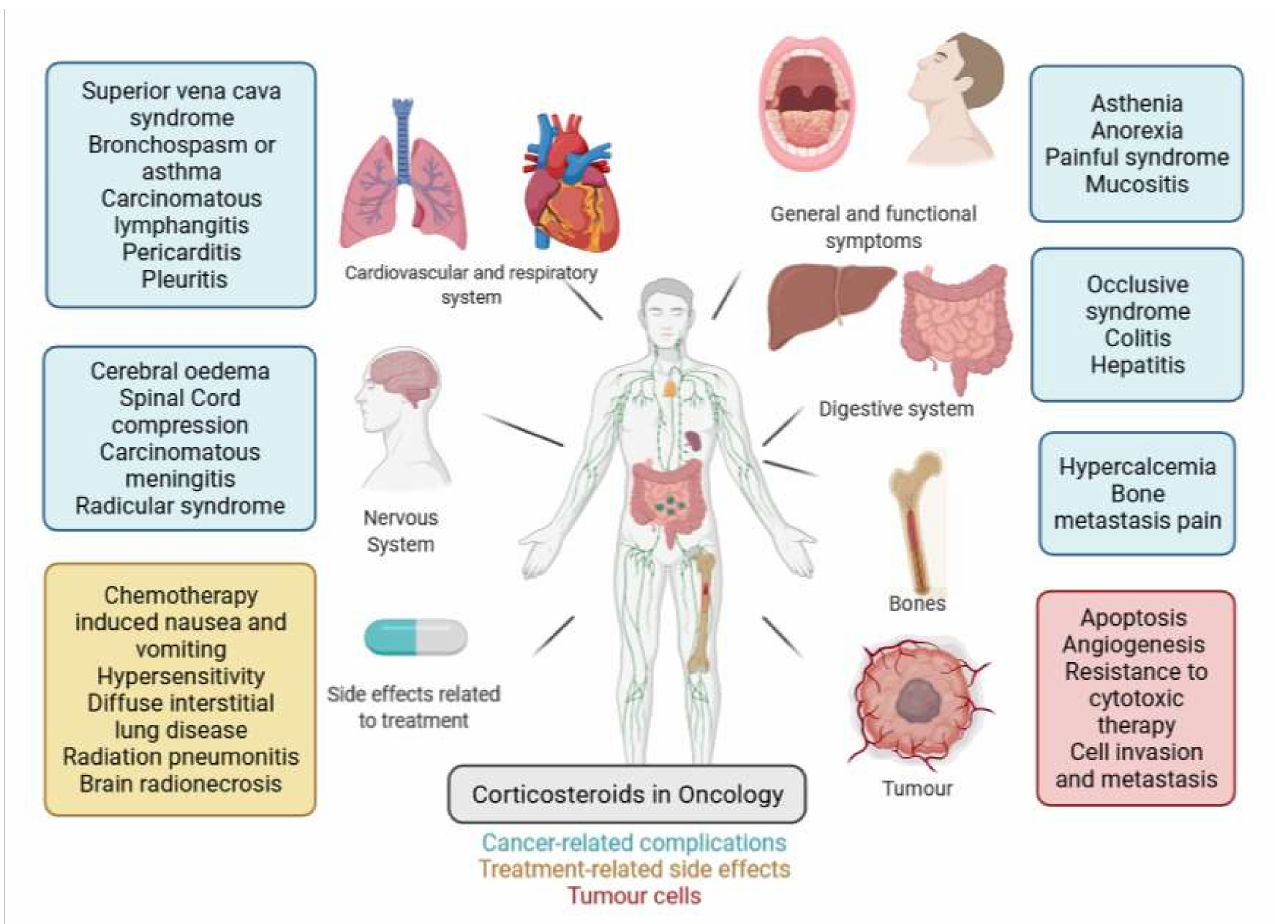
Figure 1. Indications for corticosteroid therapy in oncology (created with